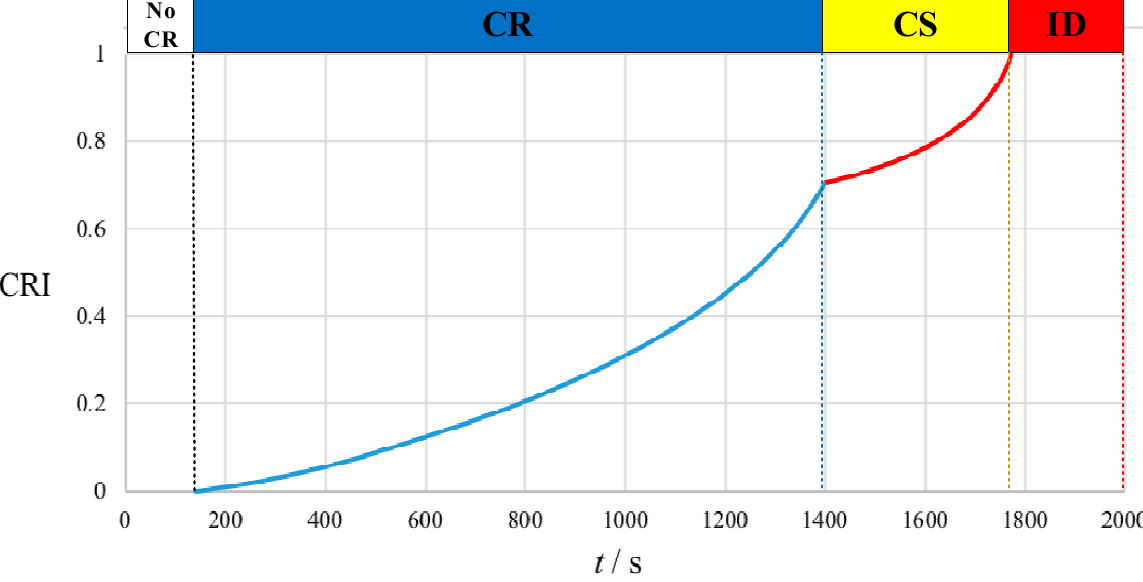
Figure 15. CRI for the stand-on vessel in an overtaking situation. Similarly, if the maximum course-alteration angle for the OS is 20 ◦ , the stand-on